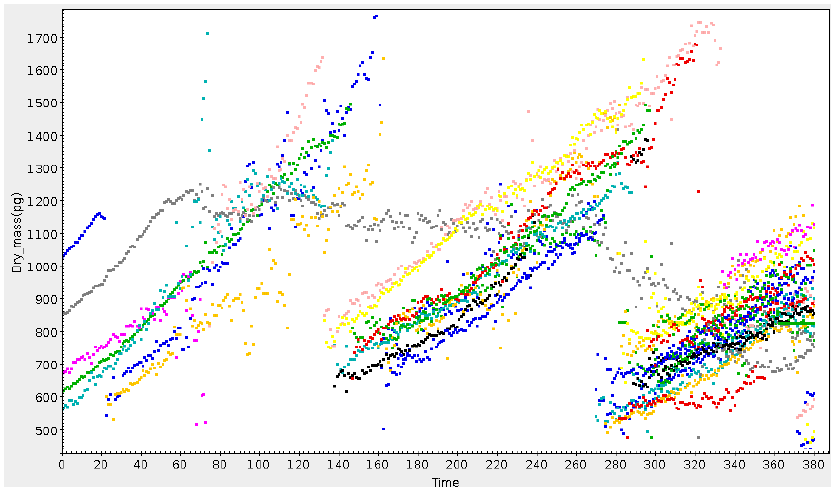
Figure 9. Growth and division of cells over time. Cell mass, represented by one colour for each distinct cell, increases until mitosis, when it is replaced by two daughter cells. In this plot the grey cell has become “blocked”, losing mass slowly instead of dividing. Credit: P. Pognonec, Université